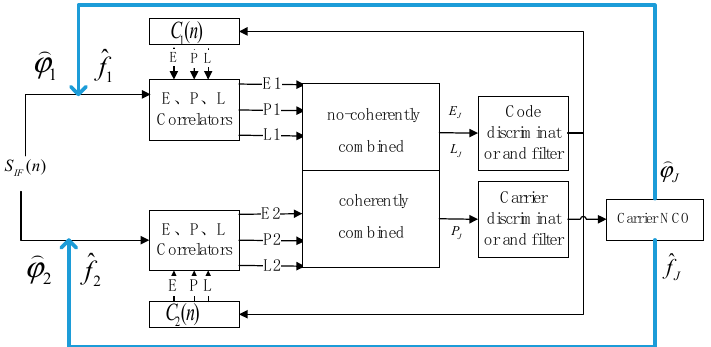
Figure 8. Block diagram of the carrier characteristic bias correction method. ˆ ϕ ˆ f J and are the carrier phase and frequency of the combined signals of signals 1 J ˆ f ˆ ϕ and 1 are the carrier phase and frequency estimates fed back to and 2, respectively. 1 ˆ f ˆ ϕ and 2 are the carrier phase and frequency esti- component 1 after correction, and 2 mates fed back by carrier NCO to component 2, respectively.